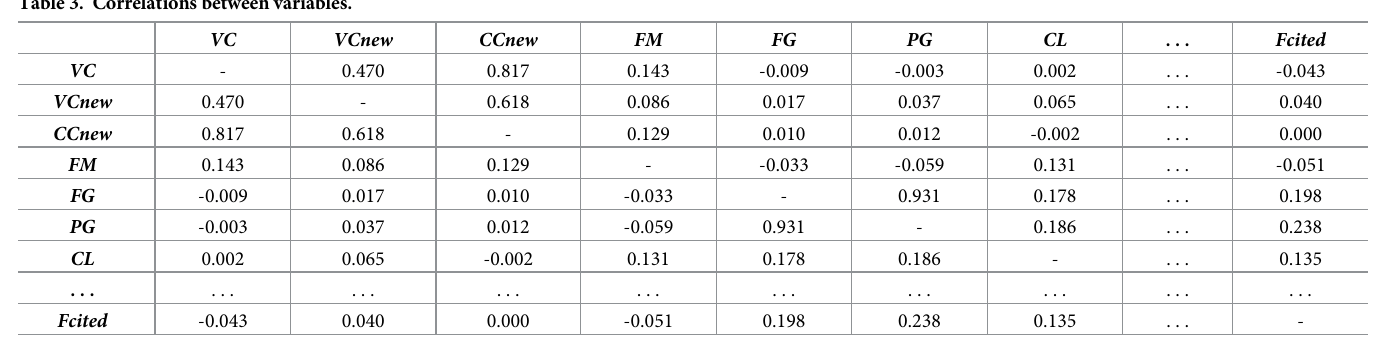
Table 3. Correlations between variables.